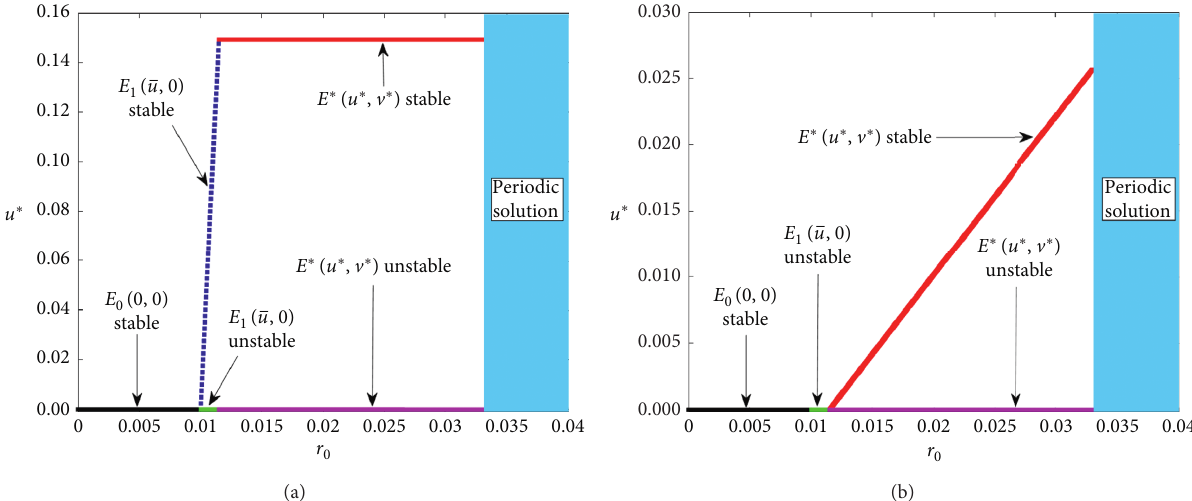
Figure 12: The transcritical bifurcation diagram with respect to the prey birth rate r response function. Other parameter values are specified as δ